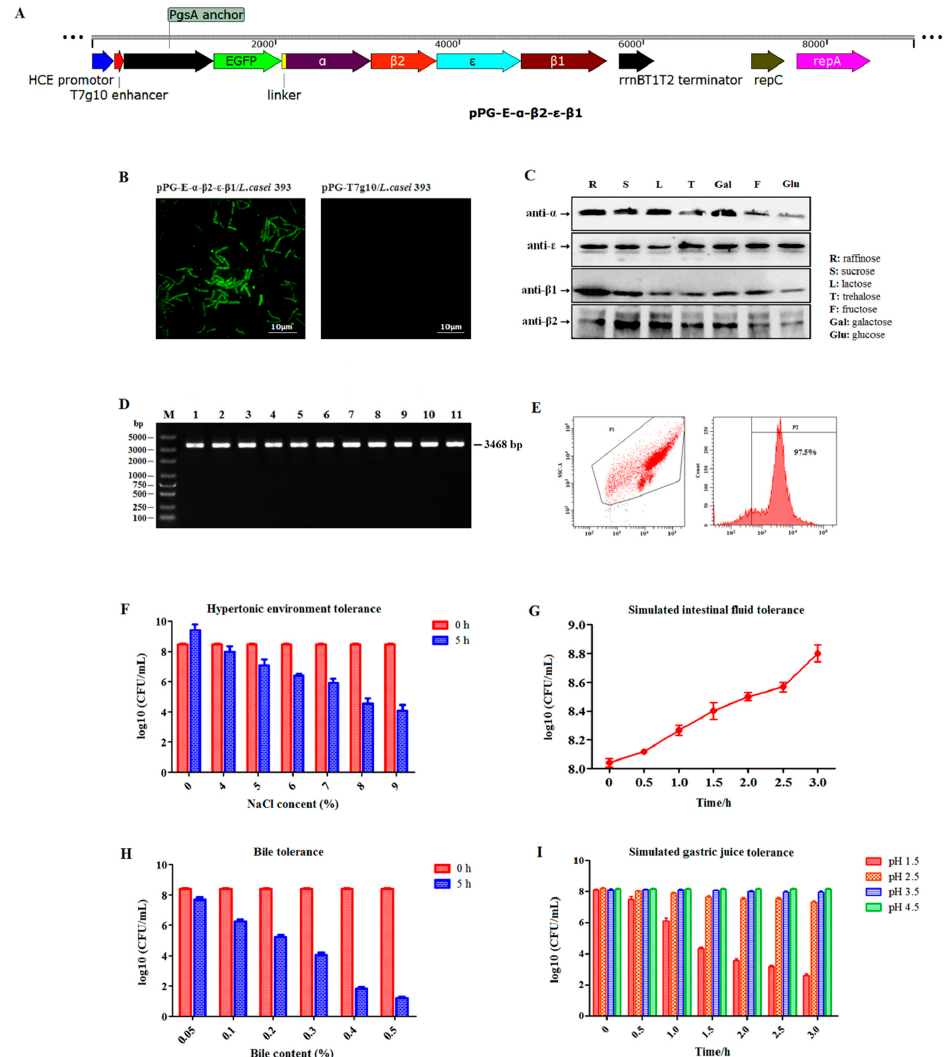
Figure 2. ( A ) Details of construction of the recombinant plasmid pPG-E- α - β 2- ε - β 1. ( B ) The constitutive expression of screening marker enhanced green fluorescent protein (EGFP) observed by ultra-high-resolution microscopy. ( C ) The constitutive expression of the fusion protein identified by western blotting using mouse anti- α , β 2, ε , and β 1 toxoid monoclonal antibody, respectively. ( D ) Segregational stability results of the recombinant lactobacillus with serial subcultures targeting the genes of interest. Lane 1: positive recombinant plasmid pPG-E- α - β 2- ε - β 1 control; lanes 2-11: the identification results of every five generations of subcultures pPG-E- α - β 2- ε - β 1/ L. casei targeting the fusion gene α - β 2- ε - β 1 for 50 generations. ( E ) Segregational stability results of the recombinant lactobacillus targeting the screening marker EGFP. The tolerance of the recombinant lactobacillus to hypertonic environment ( F ), simulated intestinal fluid environment ( G ), 0.5% bile salt ( H ), and simulated gastric environment ( I